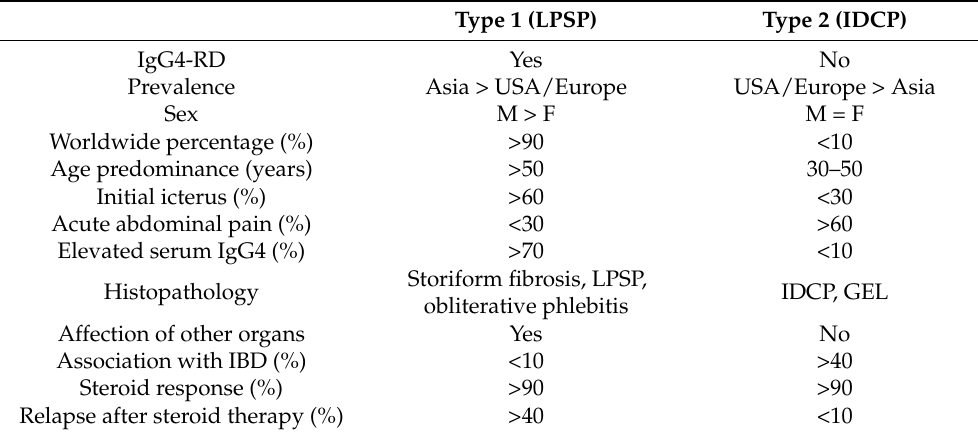
Table 6. Characteristics of and fundamental differences between type 1 and type 2 autoimmune pancreatitis (created in accordance with Webster et al.